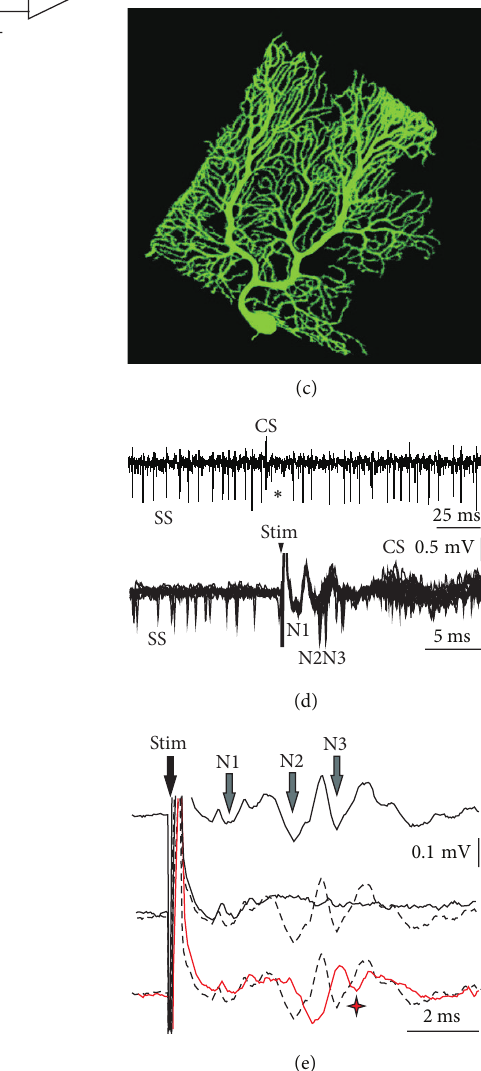
Figure 6: Experimental design and electrophysiological response to electrical stimulation of mouse whiskers. (a) Animals were prepared for chronic recordings of local field potentials (LFP) and unitary extracellular activity in the Purkinje cell layer of the Crus I/II area. Facial dermatomes of the whisker region were electrically or tactilely stimulated with a pair of needles under the skin (Stim.) pulse, respectively. Sensory information comes into the Crus I/II area from the trigeminal nucleus (Tn) in the brainstem, which receives afferent signals from the trigeminal ganglion (Tg). (b) Schematic diagram of the circuits linking the trigeminal input and the olivo cerebellar system. (c) Photography of a single PC injected by Lucifer yellow. (d) Recording of spontaneous firing behavior of a Purkinje cell (PC) shows the presence of single spikes (SS) and complex spikes (CS). The presence of a CS followed by a pause in the SS firing (asterisk) identifies this neuron as a PC. Single trials, superimposed ( 𝑛 = 11 ), show spontaneous firing before the whisker electrical stimulation (Stim) and the temporal reorganization of the firing after the stimulus. SS firing occurred at the low points of the N2 and N3 components and later. The evoked CS occurred at a latency of 9–13ms after the stimulus onset (arrowhead). (e) Long-term depression on the LFP is evident after the 8Hz stimulation protocol (red line), when the latency of the N2 components increased and the amplitude of the N3 component strongly decreased. These effects were maximal just after the 8 Hz stimulation and persisted for at least 30min. Single traces selected to compare latencies and amplitudes of LFP components; (top) before 8Hz stimulation protocol, (middle) during 8Hz stimulation, and (bottom) just after 8Hz stimulation protocol. The red asterisk indicates the LTD effect on N3 postsynaptic components after 8 Hz stimulation, ( adapted from [37] with permission